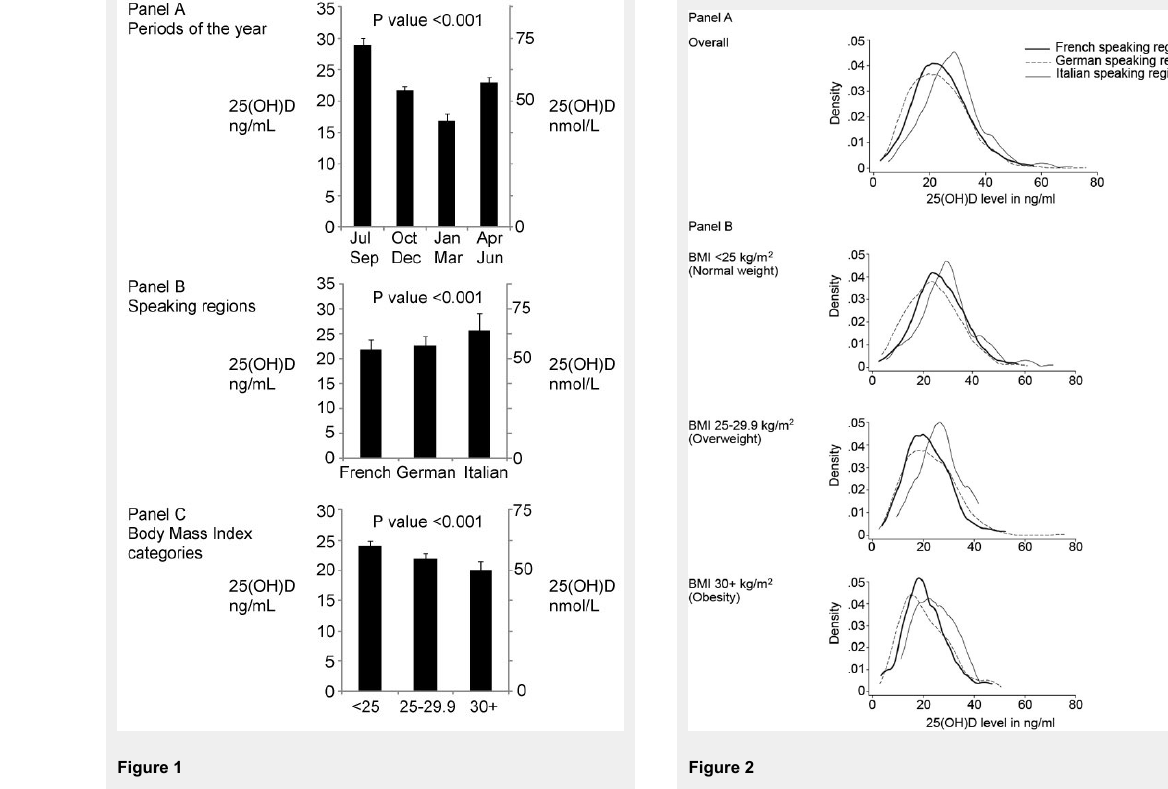
A 25(OH)D distribution by speaking regions. B 25(OH)D distribution by speaking regions, stratified by BMI